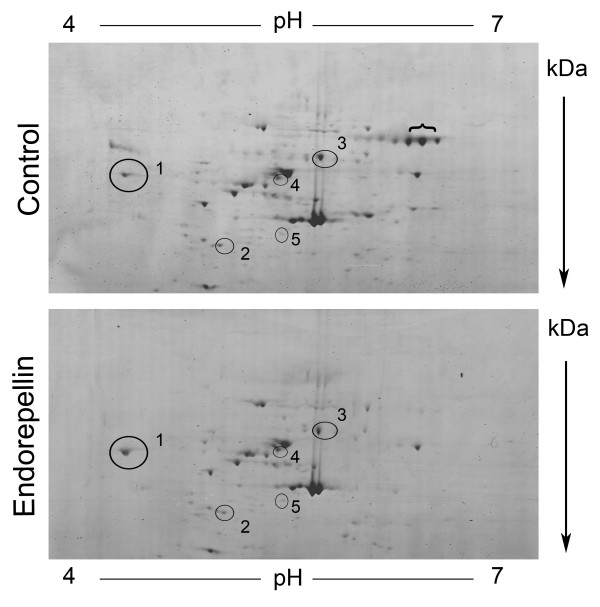
Comparative proteomic analysis of vehicle- and endorepellin-treated human endothelial cells. Representative 2-D protein profiles from vehicle- and endorepellin-treated endothelial cells are depicted with protein separation according to isoelectric point (pI, x-axis) and molecular weight (kDa, y-axis). Encircled protein spots correspond to the five proteins differentially expressed in response to endorepellin treatment. Compare calreticulin (1), β-actin (2), chaperonin/Hsp60 (3), vimentin (4) and prolyl 4-hydorxylase, β subunit (5), spot intensities in the two sets of samples. The spots under the bracket represent serum albumin by LC-MS/MS.